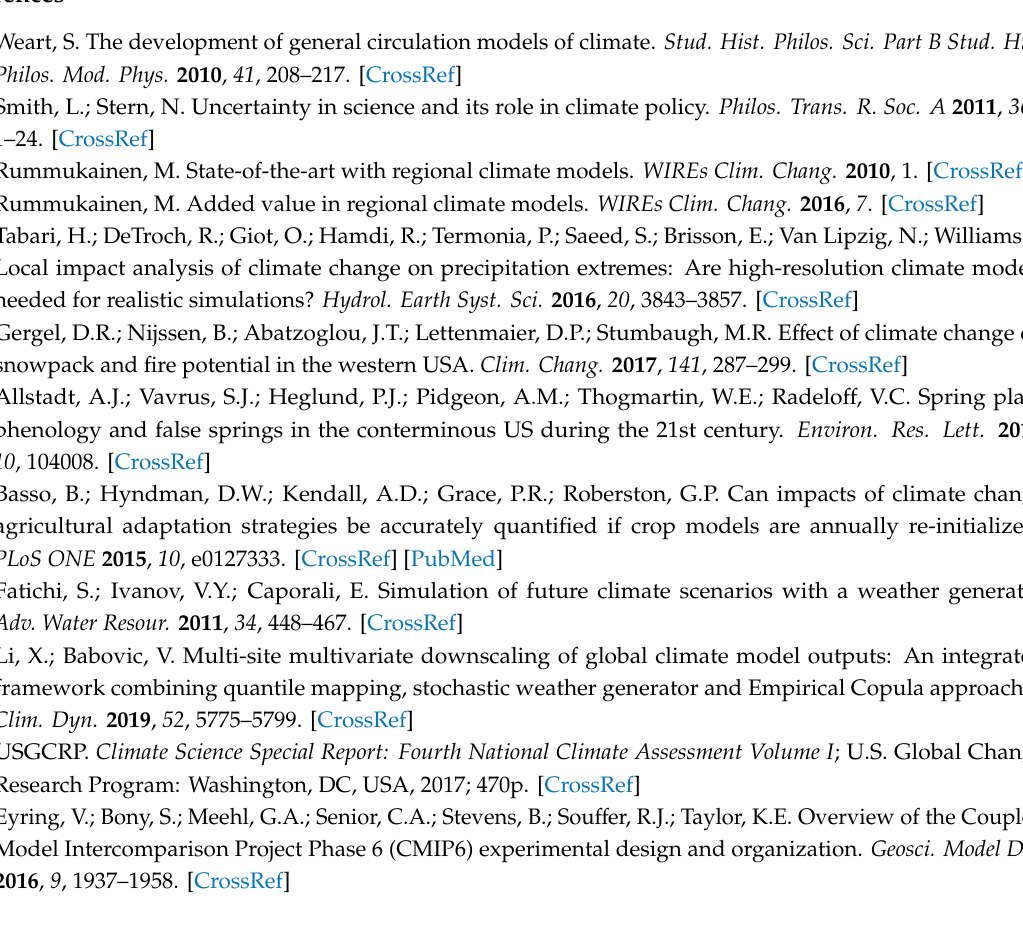
Table S1: Global Climate Models used to create both the CMIP5 and LOCA